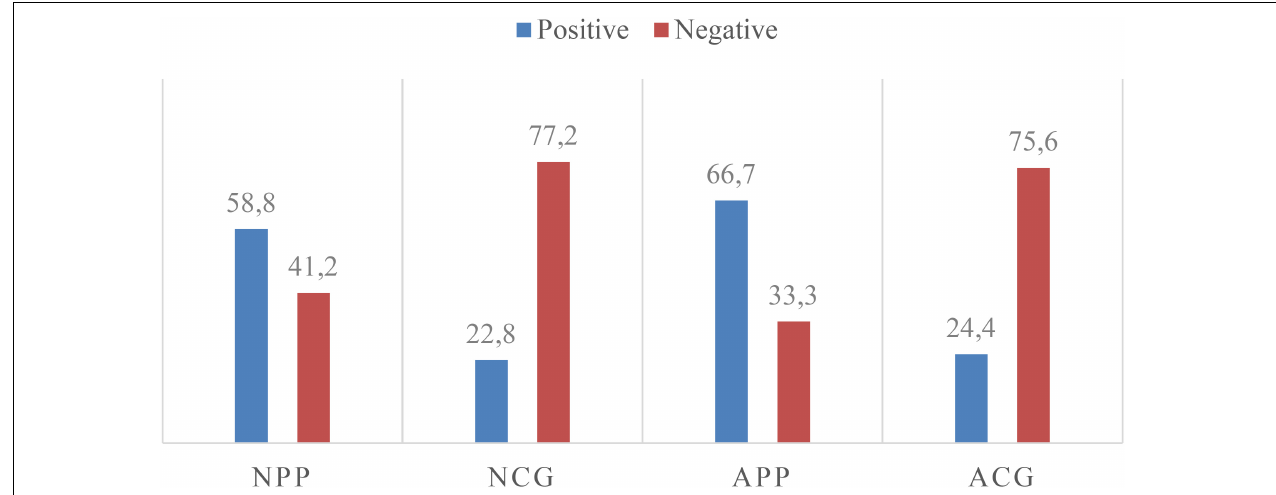
FIGURE 1 | Positive and negative feelings per site